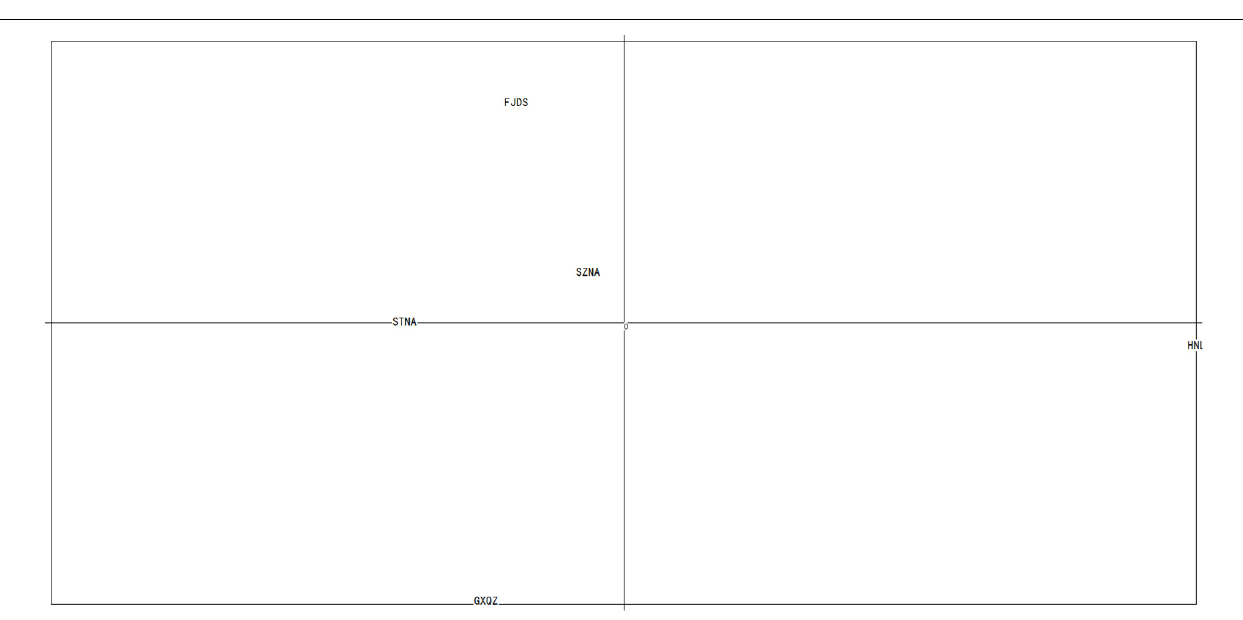
FIGURE 4 | Principal component analysis plotting the relationships of C. nobilis populations, based on a matrix of genetic distance (Nei,